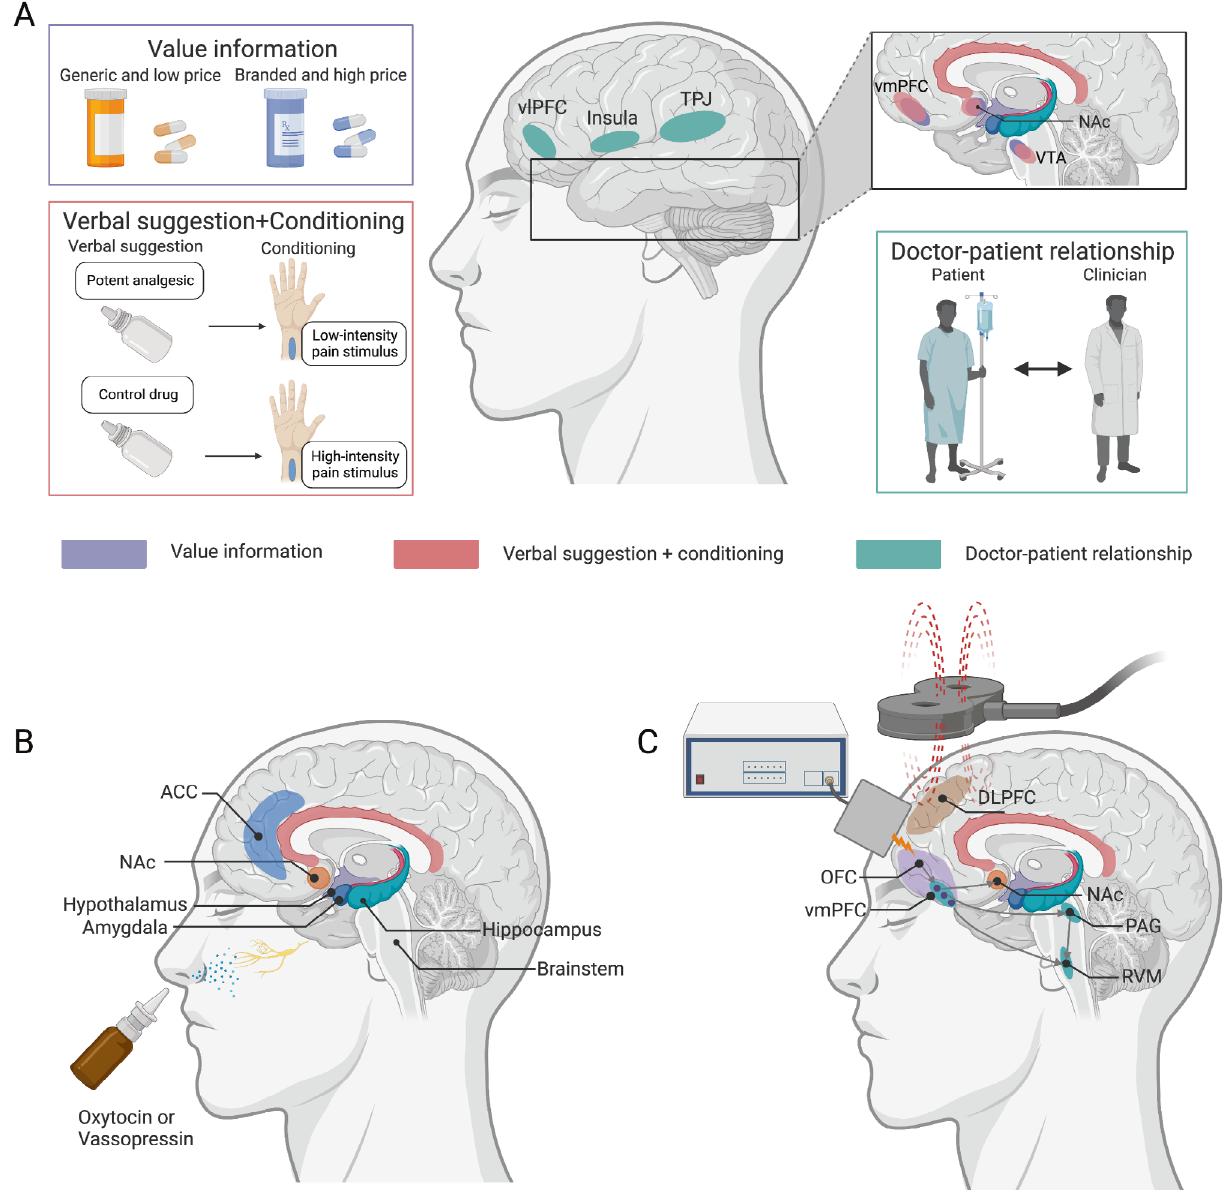
Fig. 1 Different approaches and potential neural mechanisms to harness placebo effects. A Psychosocial approaches, including valuable information and enhanced conditioning (i.e., verbal suggestion precedes conditioning), modulate the reward system (e.g., ventromedial prefrontal cortex [vmPFC], nucleus accumbens [NAc], and ventral tegmental area [VTA]). Trustful doctor – patient relationships rely on the brain-to-brain coupling in the temporoparietal junction (TPJ), insula, and ventrolateral prefrontal cortex (vlPFC). B Intranasally administered oxytocin/vasopressin travels to the brain via olfactory and trigeminal nerve fi bers and may modulate placebo-related brain activities in the anterior cingulate cortex (ACC), NAc, hypothalamus, amygdala, hippocampus, and brainstem. C Neuromodulational approaches including transcranial magnetic stimulation (TMS) and electrical stimulation (tES) target key regions in the prefrontal cortex (e.g., dorsolateral prefrontal cortex [DLPFC] and orbitofrontal cortex [OFC]) to modulate the reward system and descending pain modulation system (e.g., periaqueductal gray [PAG] and rostral ventromedial medulla [RVM]) to harness placebo magnitudes of placebo and nocebo effects [72]. Participants may have stronger placebo analgesia when the verbal suggestion proceeds rather than follows conditioning, while the order of the procedures does not affect the magnitude of nocebo hyperalgesia. Minimizing nocebo effects is of profound clinical implications.